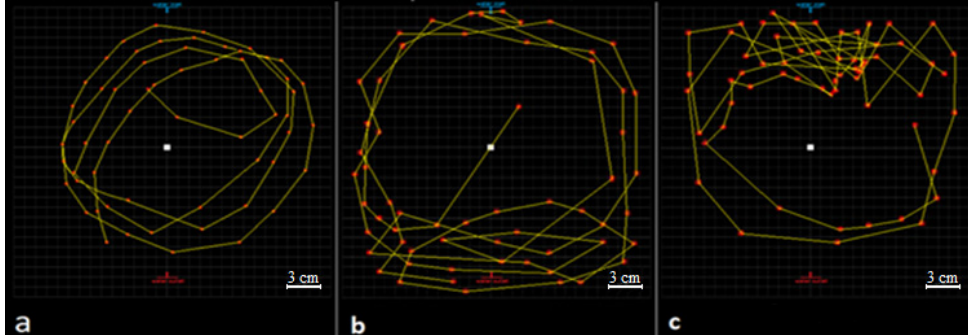
Figure 4. Fish swimming paths at different steps of the test (1 min): ( a ) swimming path of the control group at 12th time point of step 1 (nominal concentrations of glyphosate suspension was 0 mL ∙ L − 1 ); ( b ) swimming path of glyphosate treatment (treatment group) at 12th time point of step 1 (nominal concentrations of glyphosate suspension was 63.03 mL ∙ L − 1 ); ( c ) swimming path of glyphosate treatment (treatment group) at 2nd time point of step 2 (nominal concentrations of glyphosate suspension was 63.03 mL ∙ L − 1 ). Paths measured with Digimizer (MedCalc Software, Version 4.6.1) on a Windows platform. The yellow lines are fish swimming path.